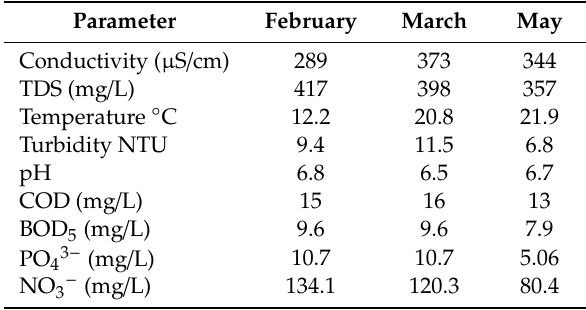
Table 1. Water quality data of the university hospital wastewater e ffl uent of Ioannina city.